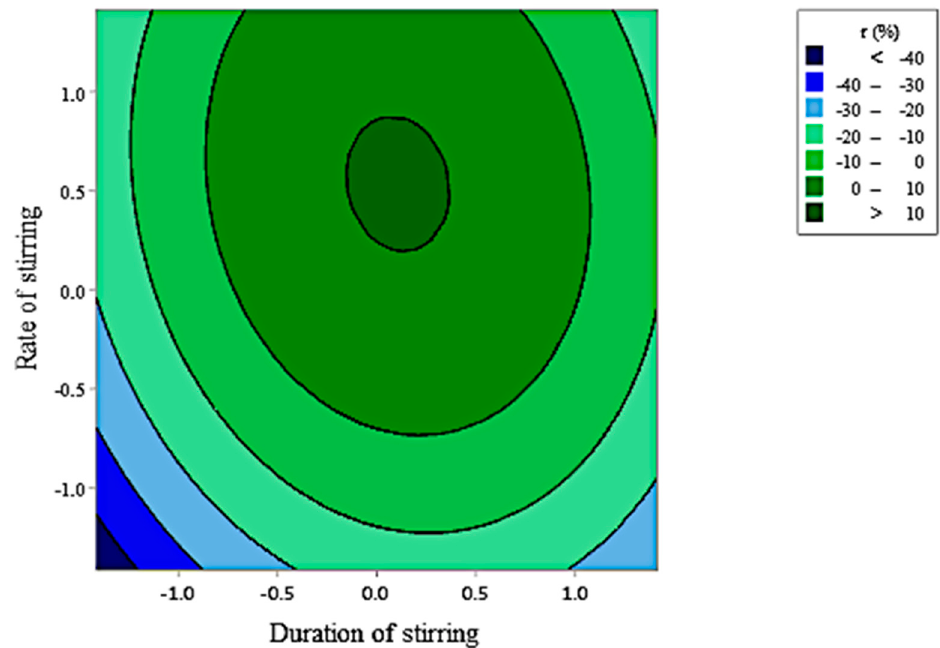
Figure 11. Contour plots showing the crossed effect of duration (D) and rate of stirring (R) on the retention rate (r) of citronella essential oil by GCD-2.